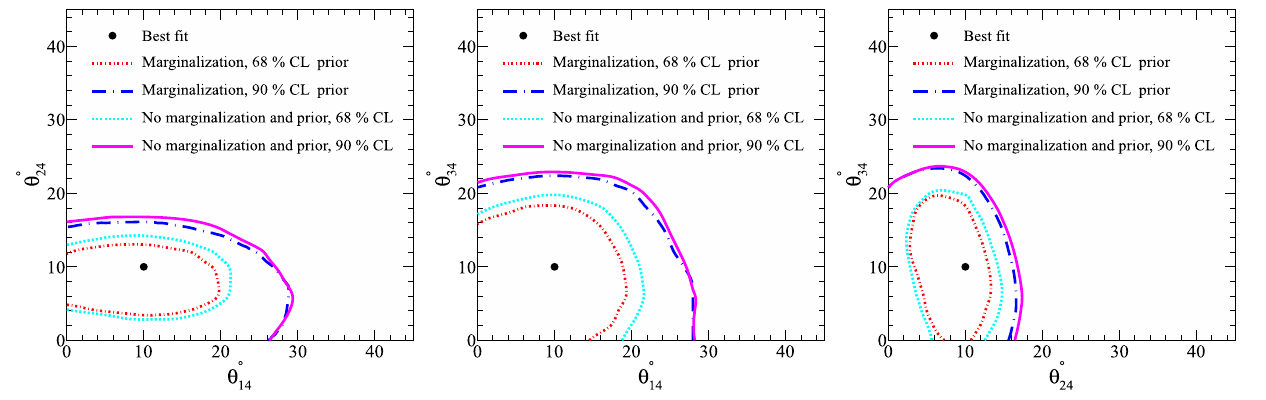
= 1eV 2 . We Fig. 9 The expected allowed areas in the θ 14 − θ 24 plane ( left-hand data is generated at θ 14 = θ 24 = θ 34 = 10 ◦ and at (cid:2) m 2 41 panel ), θ 14 − θ 34 plane ( middle panel ), and θ 24 − θ 34 plane ( right-hand marginalize the χ 2 over (cid:2) m 2 and the remaining sterile mixing angle, 41 panel ), expected from 1Mt-yr of ICAL data. The standard 3-generation viz., θ 34 in the left-hand panel , θ 24 in the middle panel and θ 14 in the oscillation parameters are taken as sin 2 θ 12 = 0 . 3, sin 2 2 θ 13 = 0 . 1, right-hand panel . The priors considered are described in Sect. = 7 . 5 × 10 − 5 eV 2 , (cid:2) m 2 = 2 . 4 × 10 − 3 eV 2 . The sin 2 θ 23 = 0 . 5, (cid:2) m 2 21 31